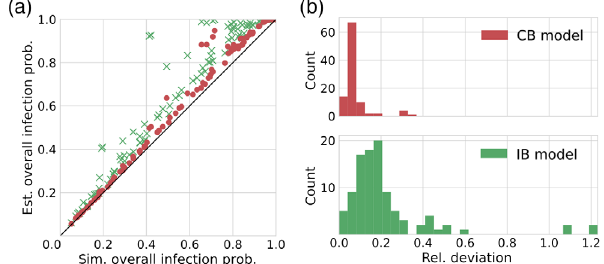
FIG. 15. (a) Comparison between simulated and estimated vulnerability. We compute the cumulative infection probability in the limit t → ∞ , also denoted as vulnerability. The comparison with CB and IB estimations is visualized by red circles and green crosses, respectively. Each value corresponds to the vulnerability of a node given the same outbreak location and disease para- meters as in Fig. 1. (b) Relative deviation of the estimated values with respect to MC simulations. The numerical values are averaged over 10 5